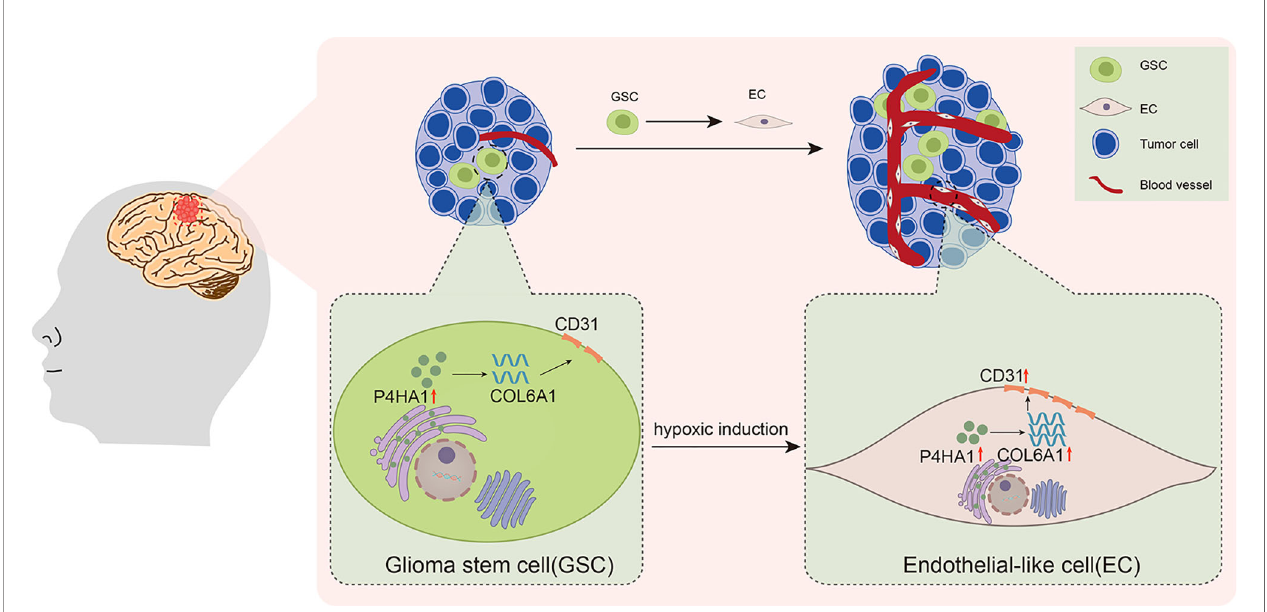
FIGURE 8 | Schematic illustration of the activities of P4HA1, COL6A1, and CD31 in the process of GSCs transdifferentiation into ECs in